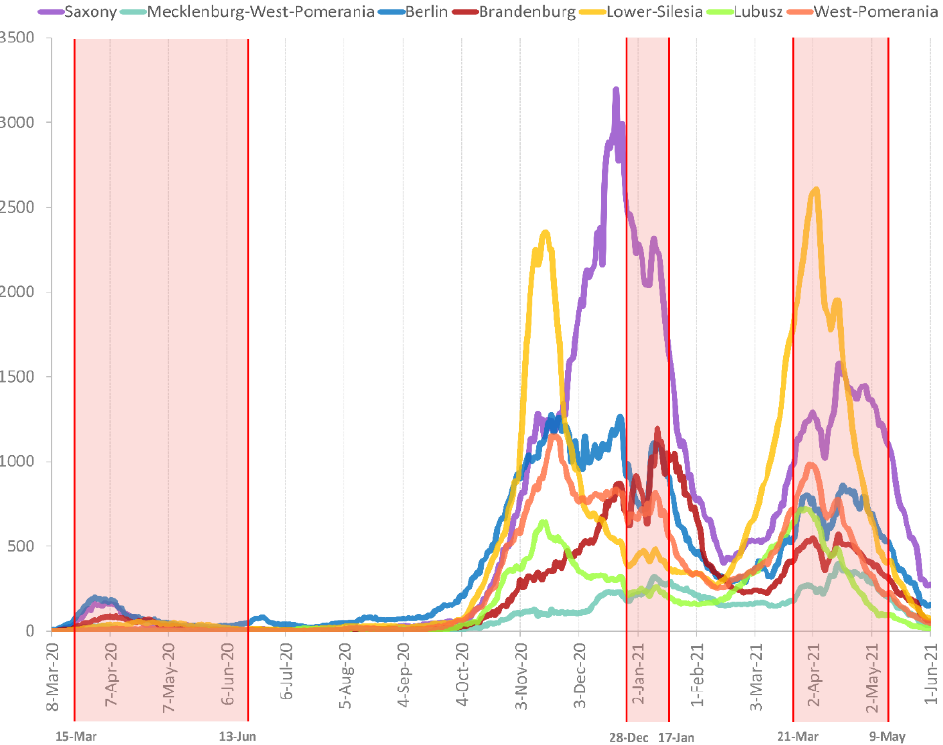
Figure 2. Comparison of daily confirmed COVID-19 cases in the seven studied provinces. The lines represent a 7-day rolling average. Three red rectangles range the time of most severe, restrictive measures implemented at the border — the first and the second closure introduced by Poland authorities, the third one made by the German government.